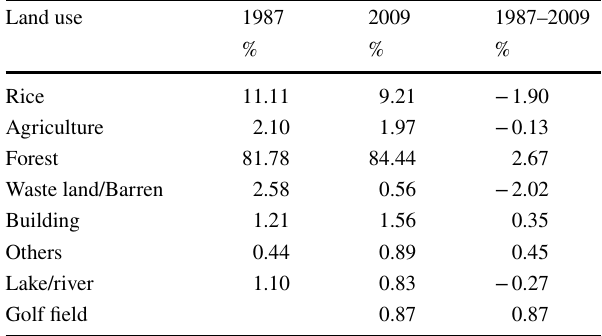
Table 4 Land-use changes in Kase River basin between 1987 and 2009